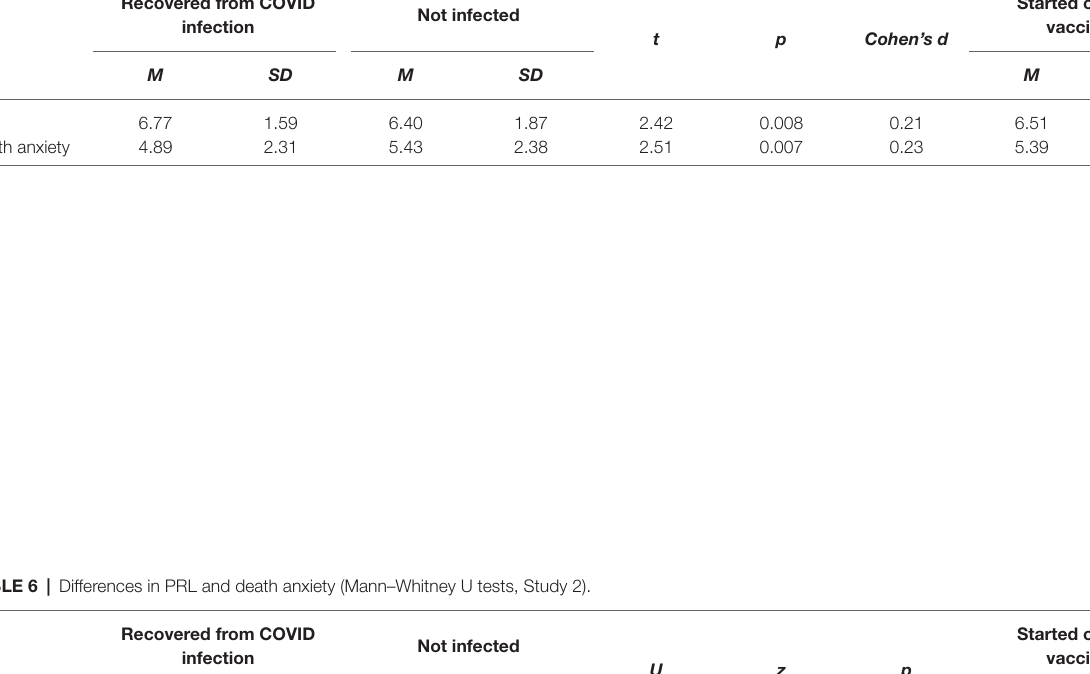
Started or finished vaccination